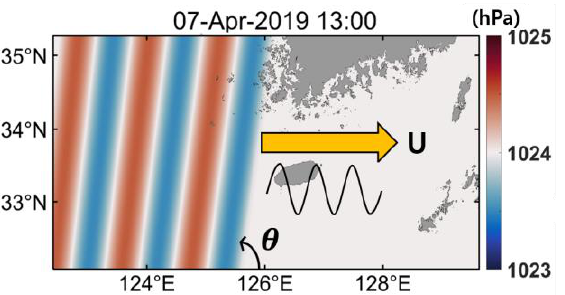
Figure 5. Eastward propagation of atmospheric pressure disturbances with a moving speed ( U ) and angle (θ) at 13:00 on 7 April 2019. The angle of a moving isobar was measured counterclockwise due east. The arrow represents the moving direction of the atmospheric pressure disturbances. The waves under the arrow represent a schematic sinusoidal form of the atmospheric pressure disturbances.